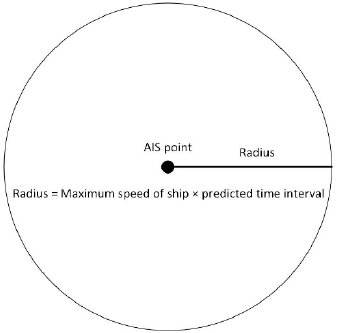
Figure 2. Expanded area.